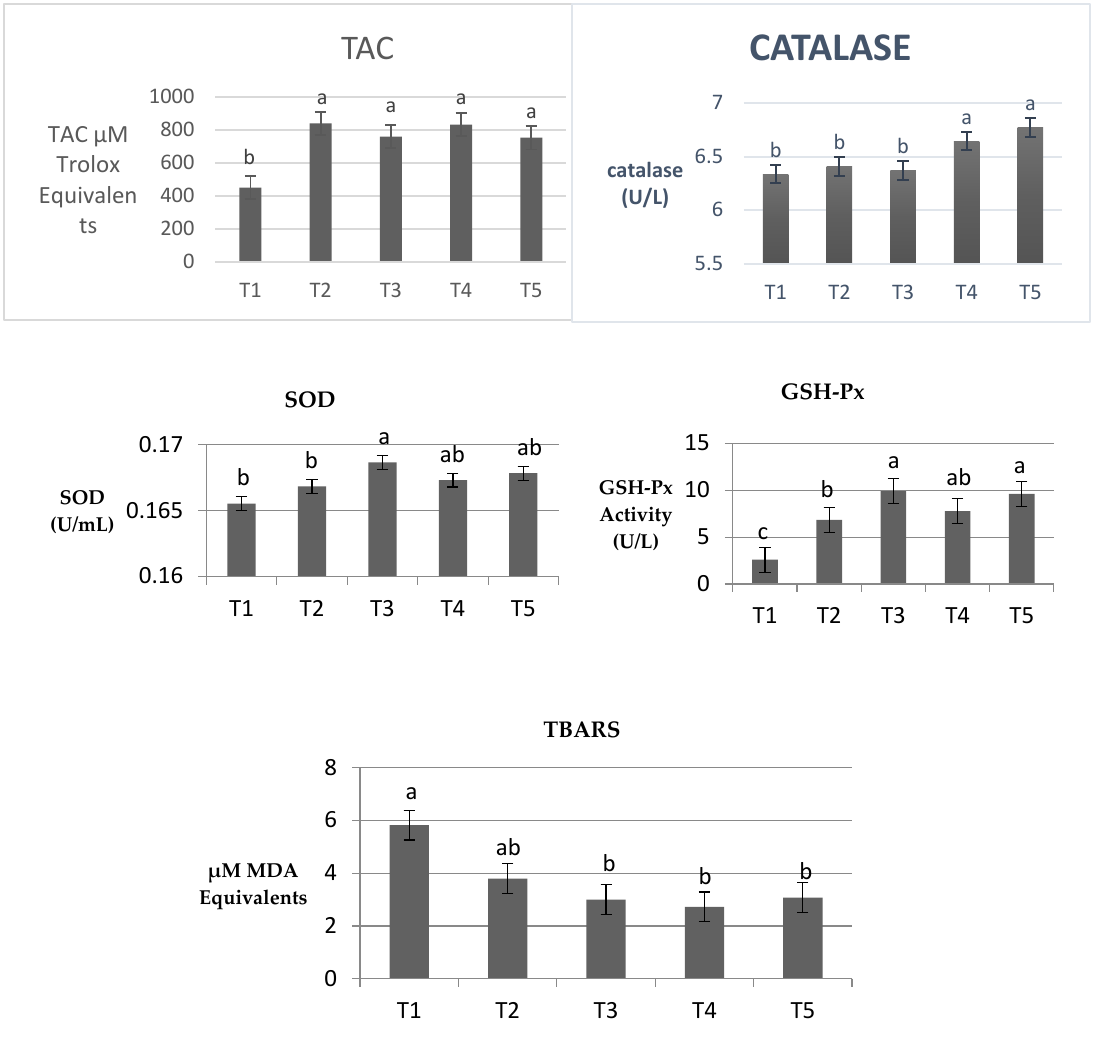
Figure 2. E ff ects of inorganic selenium and di ff erent sources of bacterial selenoprotein on meat Figure 2. Effects of inorganic selenium and different sources of bacterial selenoprotein on meat antioxidant biomarkers. a,b,c Bars with no common letter di ff er significantly ( p < 0.05). T1: basal diet, antioxidant biomarkers. a,b,c Bars with no common letter differ significantly ( p < 0.05). T1: basal diet, T2: basal diet + 0.3 mg / kg feed sodium selenite, T3: basal diet + 0.3 mg / kg feed ADS1 Se, T4: basal diet T2: basal diet + 0.3 mg/kg feed sodium selenite, T3: basal diet + 0.3 mg/kg feed ADS1 Se, T4: basal diet + 0.3 mg / kg feed ADS2 Se, T5: basal diet + 0.3 mg / kg feed ADS3 Se. TAC: total antioxidant capacity; + 0.3 mg/kg feed ADS2 Se, T5: basal diet + 0.3 mg/kg feed ADS3 Se. TAC: total antioxidant capacity; SOD: superoxide dismutase; GPX: glutathione SOD: superoxide dismutase; GPX: glutathione peroxidase.